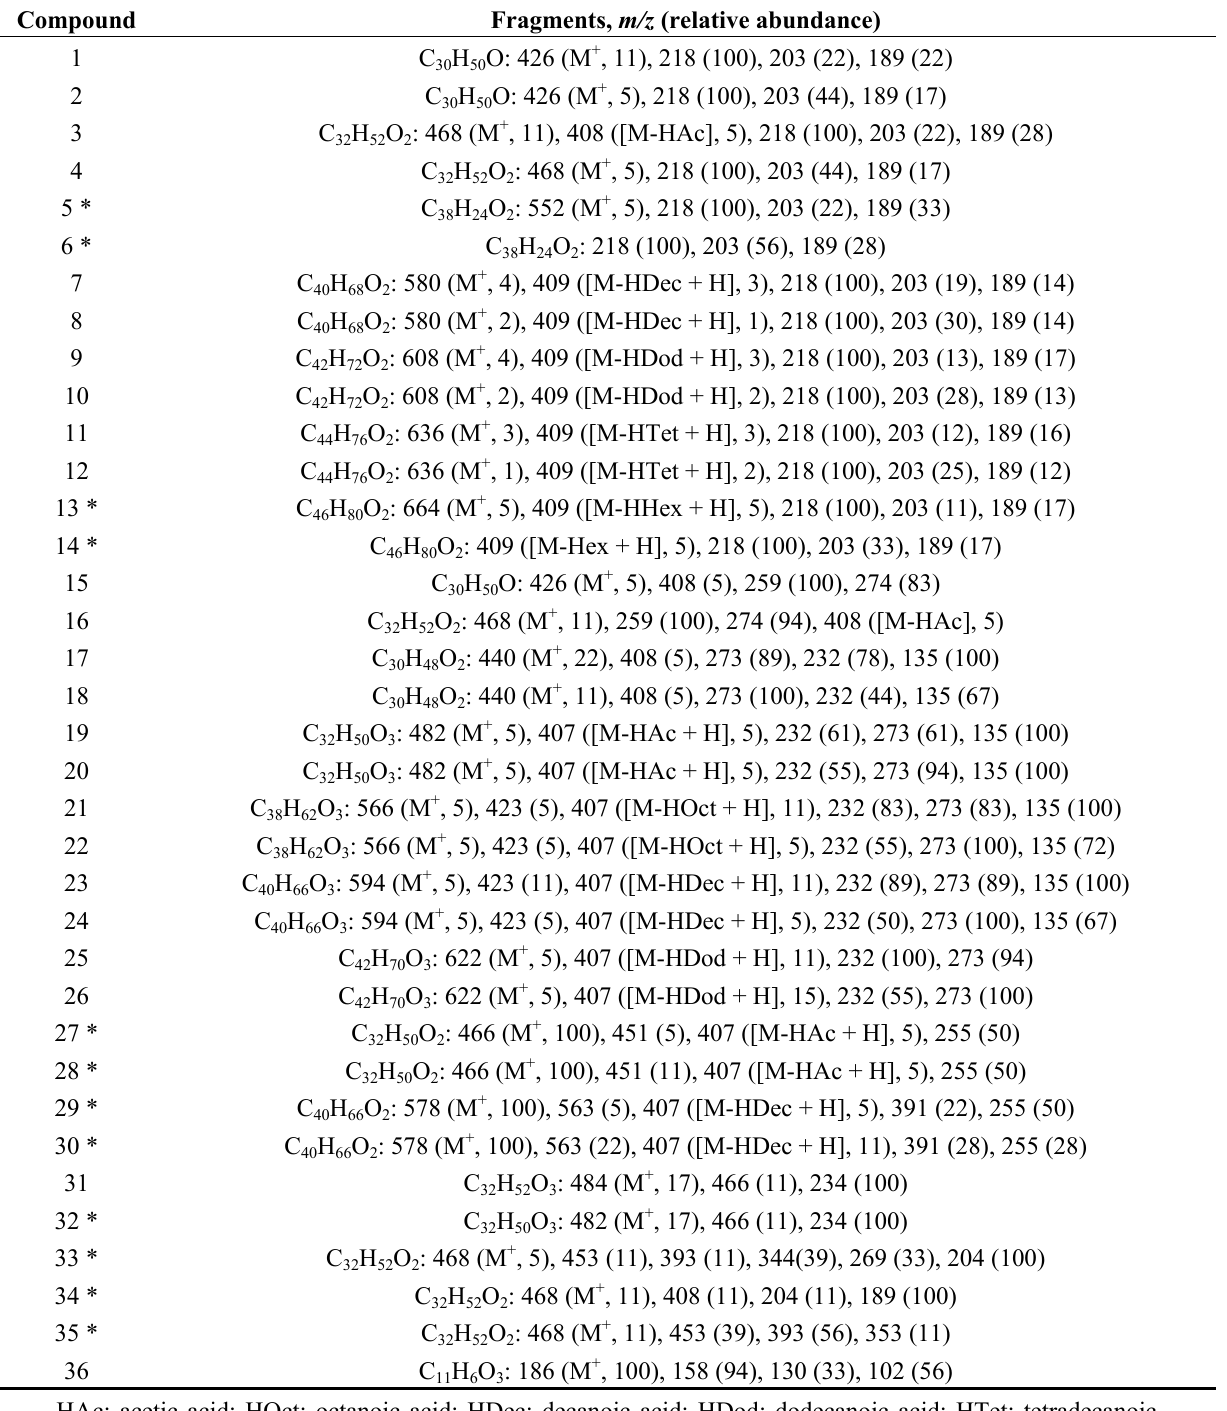
Table 1. Relevant MS data of the compounds identified from Dorstenia arifolia (EI, 70 eV). Compound Fragments, m/z (relative